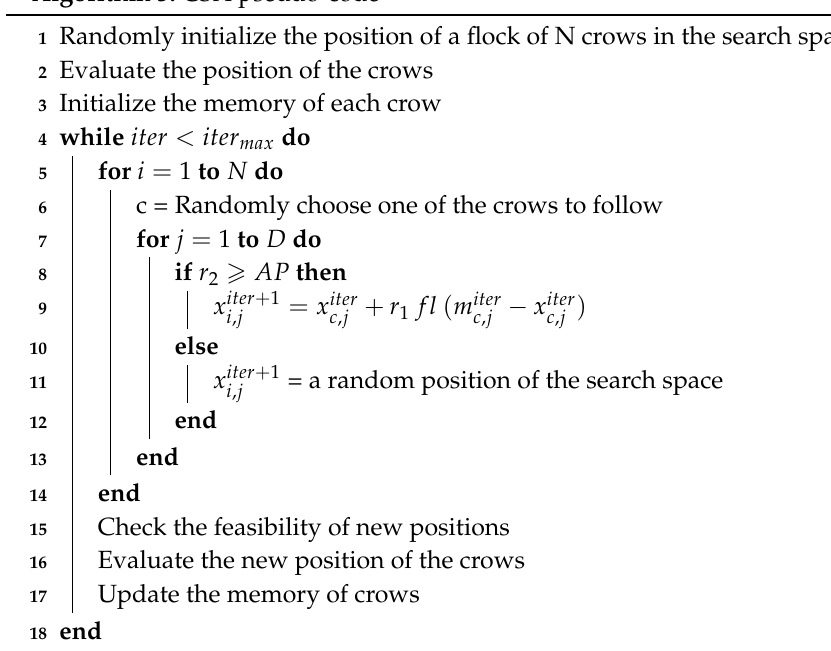
Algorithm 3: CSA